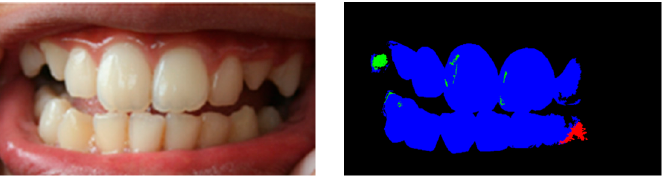
Figure 4. An image in the class Normal was misclassified as Stage 3 if Line 3 in Algorithm 4 was removed, because the segmented image has r opaque = 1.63% (green color) and r brown = 1.35% (brown color).